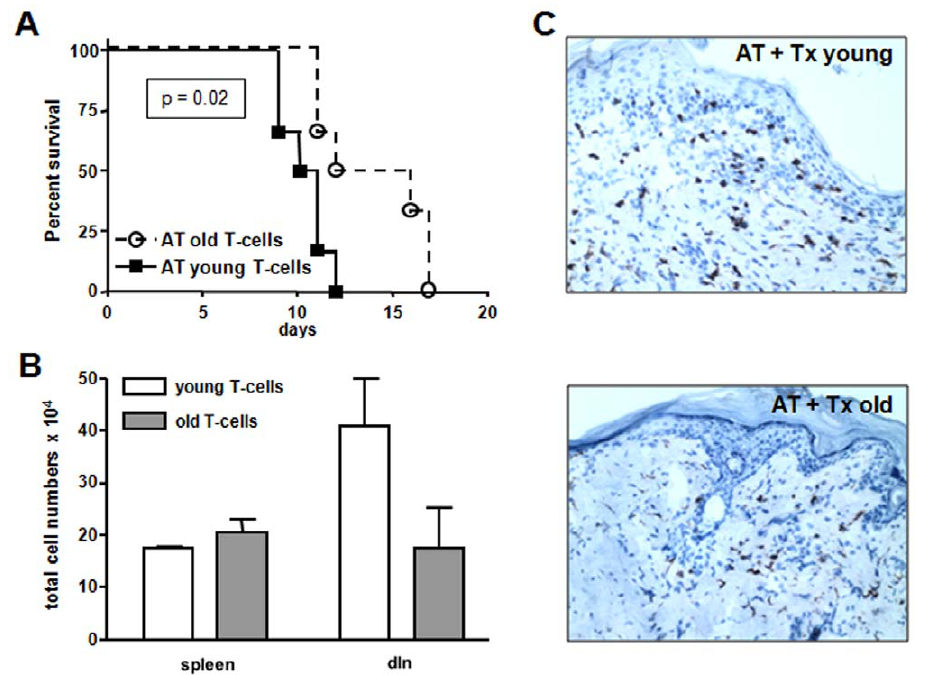
Figure 7. Impaired CD4 + T-cell expansion leads to prolonged graft survival. Impaired proliferation of alloantigen-specific CD4 + T-cells leads to prolonged graft survival in old skin graft recipients. Nude B6 mice were engrafted with two bm12 skin transplants following adoptive transfer of young or old 2 6 10 6 transgenic CD4 + ABM T-cells. In line with the reduced CD4 + T-cell response in old WT recipients skin graft survival was significantly prolonged following transfer of old alloreactive CD4 + T-cells ( A ). One week after transplantation spleen, dLN and ndLN were harvested and leukocytes were stained for CD4 + , V a 2 + and V b 8 + expression to assess proliferation of adoptively transferred T-cells ( B ). In parallel, skin grafts were stained for graft infiltrating CD4 + T-cells ( C ). At day 7, absolute numbers of adoptively transferred CD4 + T-cells were counted in different lymphatic compartments in order to determine T-cell proliferation. A significantly reduced proliferation of old tg CD4 + T-cells was accompanied by decreased graft infiltration, underscoring a delayed rejection response ( B and C